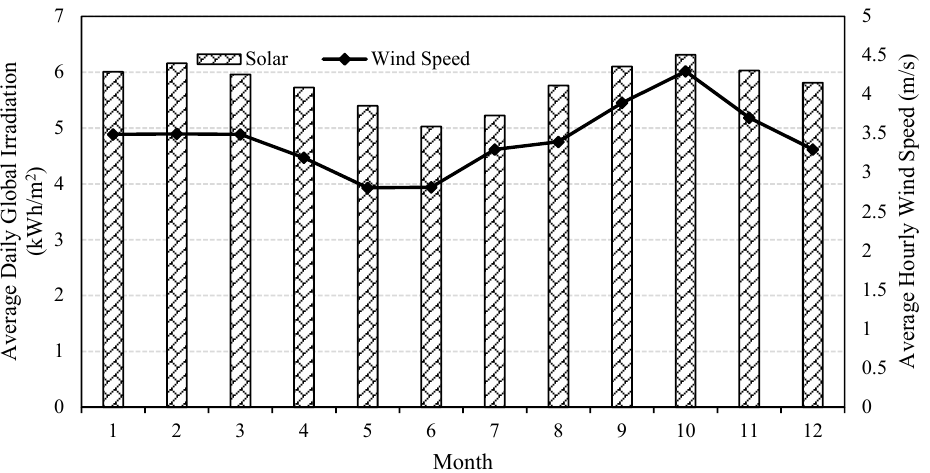
Figure 1. The average hourly wind speeds at ground level in addition to the average daily solar radiation on a horizontal surface throughout the year in Gwanda.